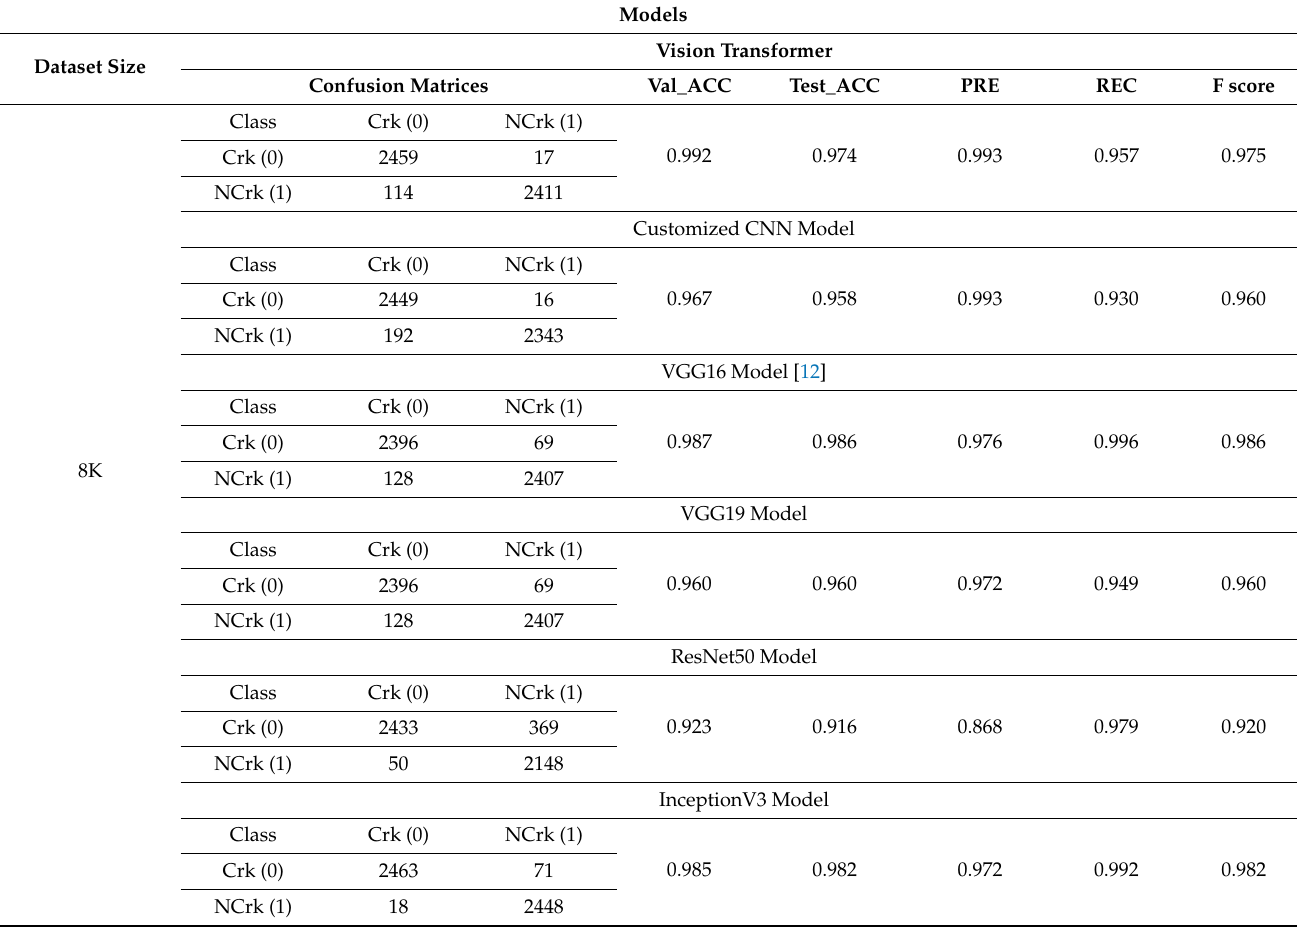
Table 4. Results of ViT and DL models [12] on the Concrete 8K dataset.